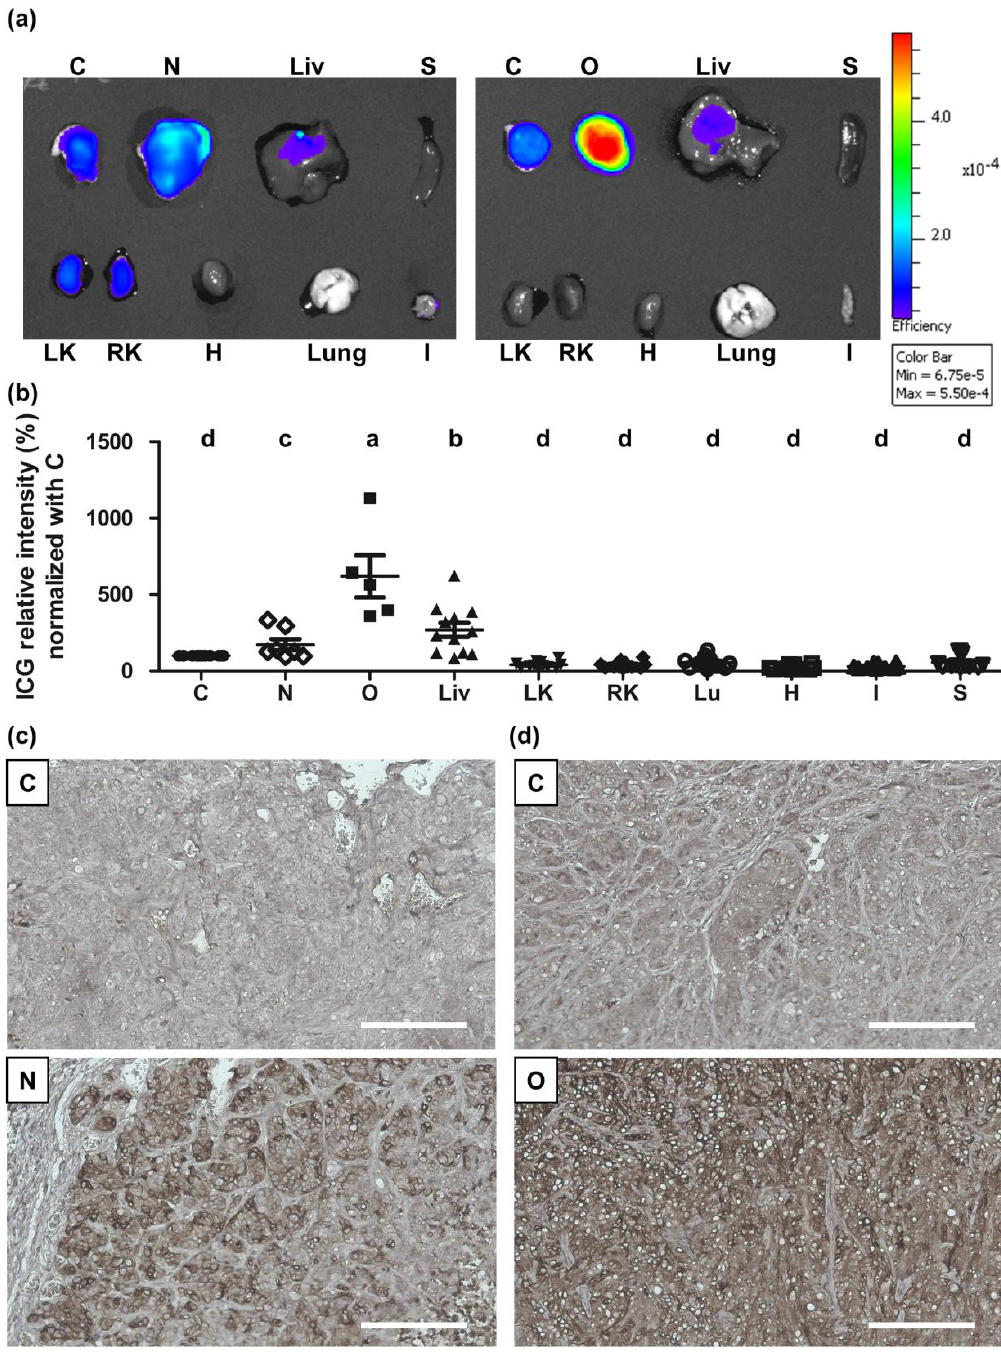
Figure 5. ICG intake ex vivo in the IVIS. After the administration of ICG for 2 d, we sacrificed the mice to evaluate the ICG signals using IVIS. ( a ) Ex vivo IVIS of NTCP - and OATP1B3 -expressing tumor-bearing mice. C: control tumor; N: NTCP -expressing tumor; O: OATP1B3 -expressing tumor. Liv: liver; LK: left kidney; RK: right kidney; Lu: Lung; H: heart; S: spleen; I: small intestine. ( b ) Quantification of ex vivo IVIS data from NTCP - and OATP1B3 -expressing tumor-bearing mice; N = 7 and N = 5, respectively. Error bars indicate the SEM. a, b, c, and d indicate statistically significant differences among groups. ( c ) Tumors stripped from control and NTCP -expressing tumor-bearing mice stained for NTCP. ( d ) Tumors stripped from control and OATP1B3 -expressing tumor-bearing mice stained for NTCP. The nuclei were stained using hematoxylin. Scale bar: 100 μm.